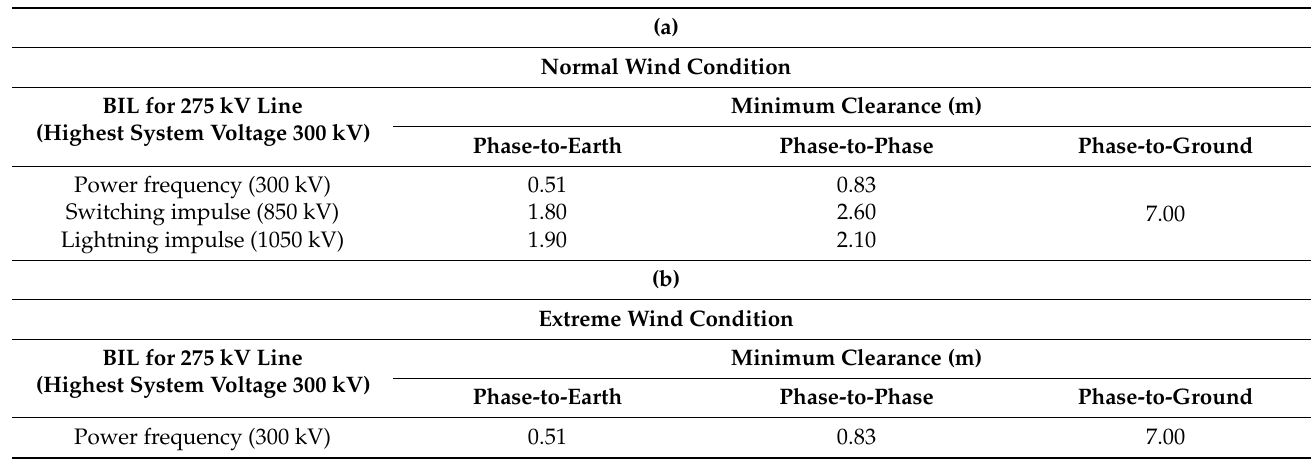
Table 2. Requirement of electrical clearance under ( a ) normal, and ( b ) extreme wind conditions [33–35].